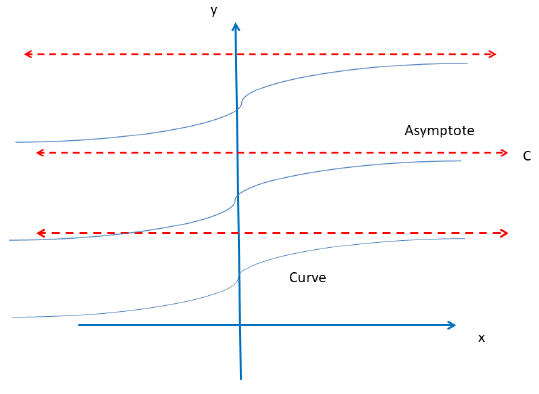
Figure 4. Horizontal asymptotes